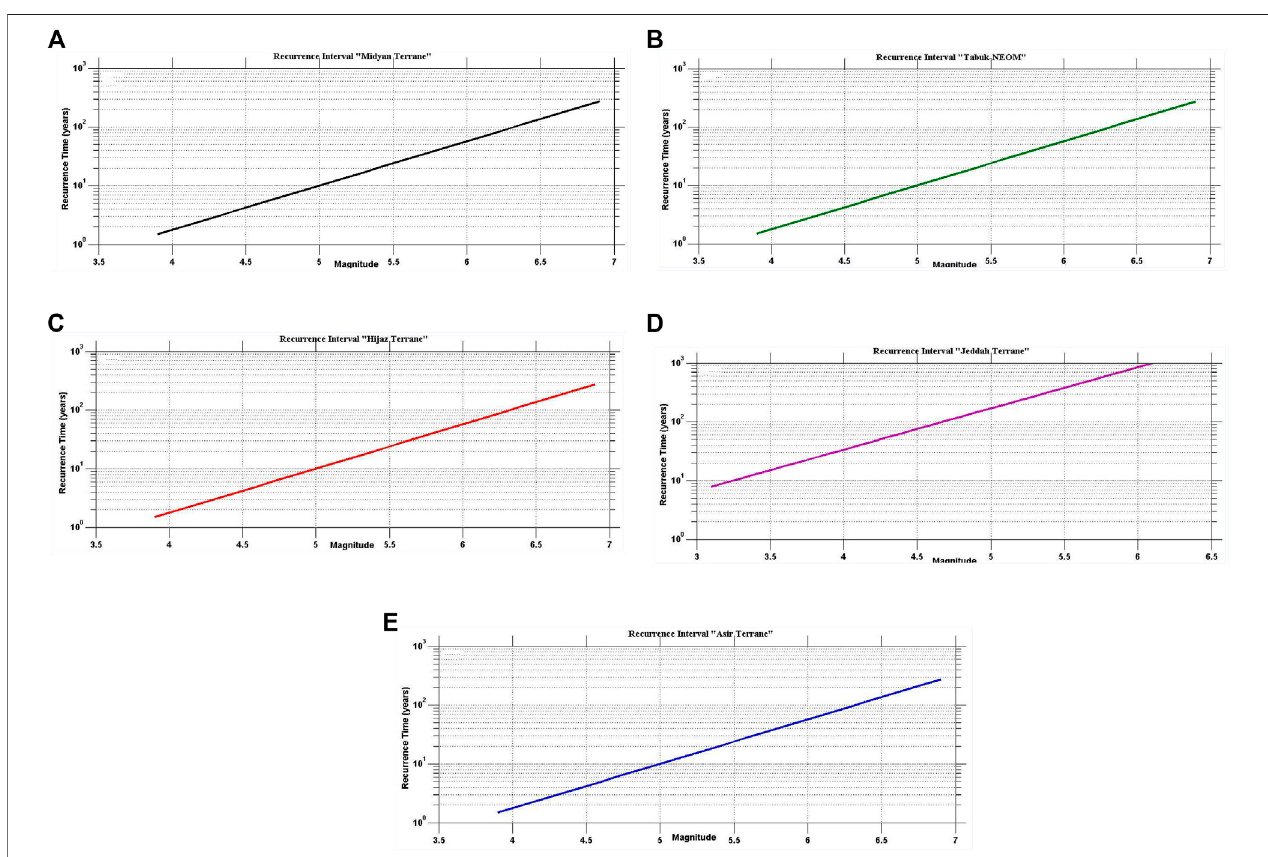
FIGURE 14 | (A – E) The recurrence interval for all earthquake magnitudes as represented by the color legend.